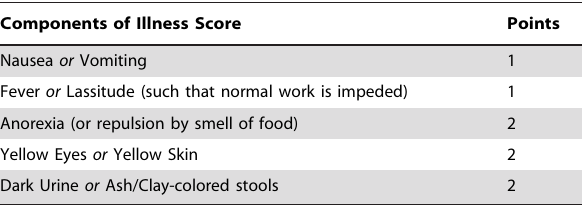
Table 1. Sign and symptom-based visual algorithm (http:// bit.ly/HepE_Card) used to identify candidate cases of acute viral